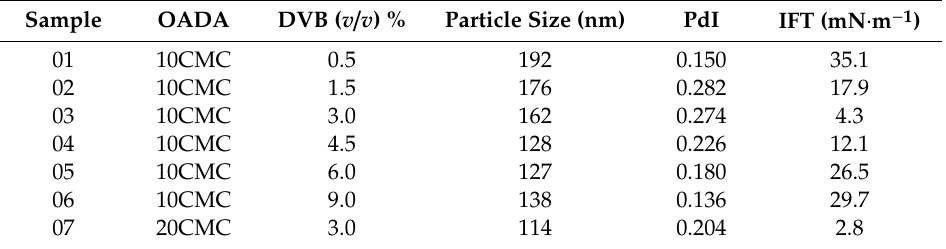
Table 2. Particle size and Interfacial tension of PSNP obtained by polymerization with di ff erent OADA and DVB